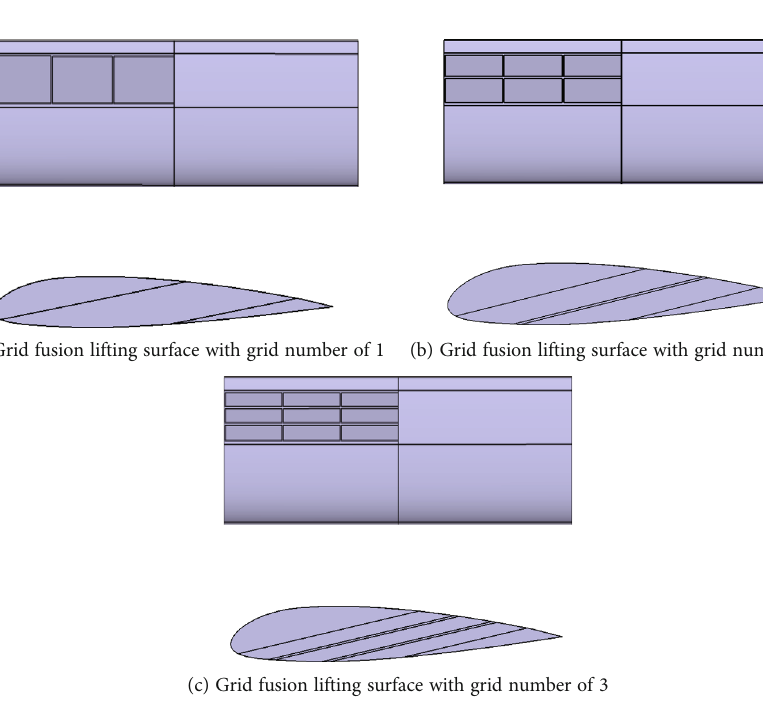
Figure 11: Calculation model of grid fusion lifting surface with di ff erent diversion angles3.